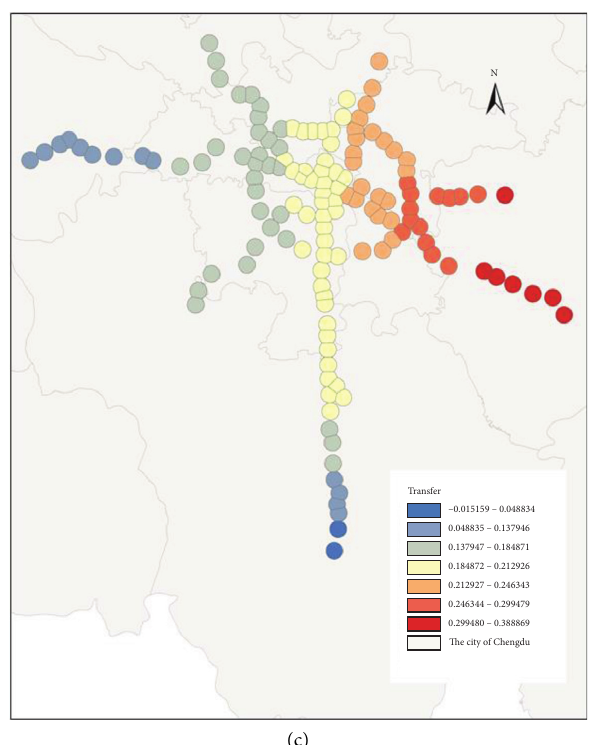
Figure 13: (a–c) Spatial distribution of three variables, new station , terminal , transfer , etc. in the MGWR model.